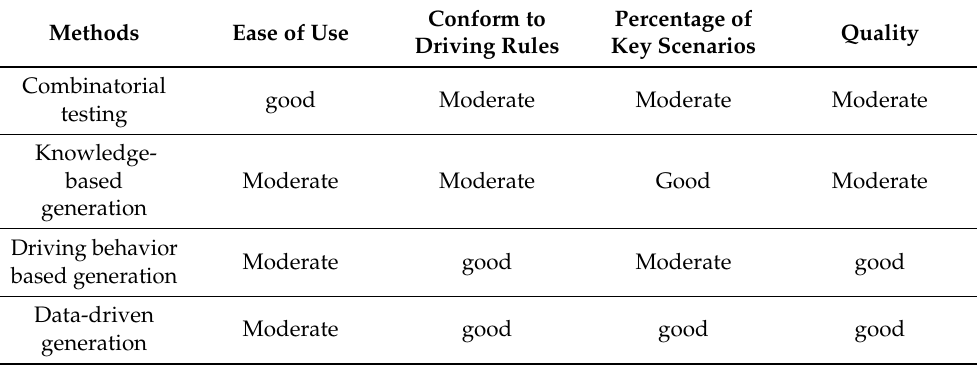
Table 5. A comparison of different dynamic scenario generation